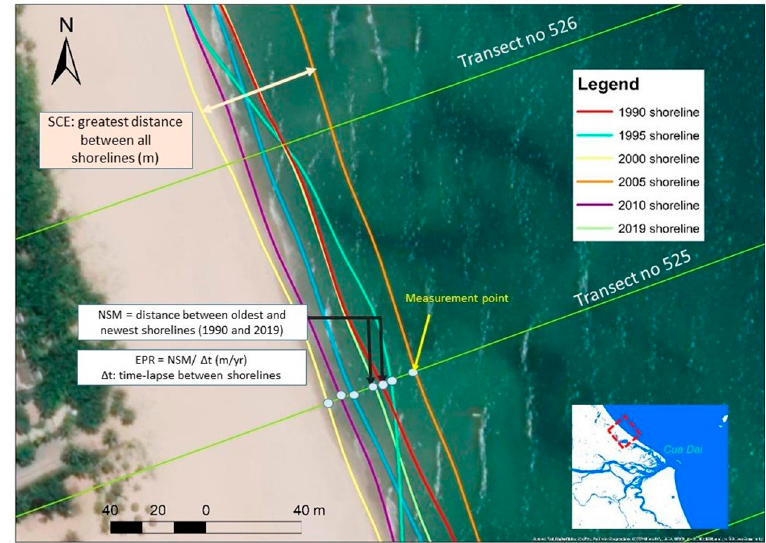
Figure 5. Illustration for the EPR and NSM parameters in DSAS.